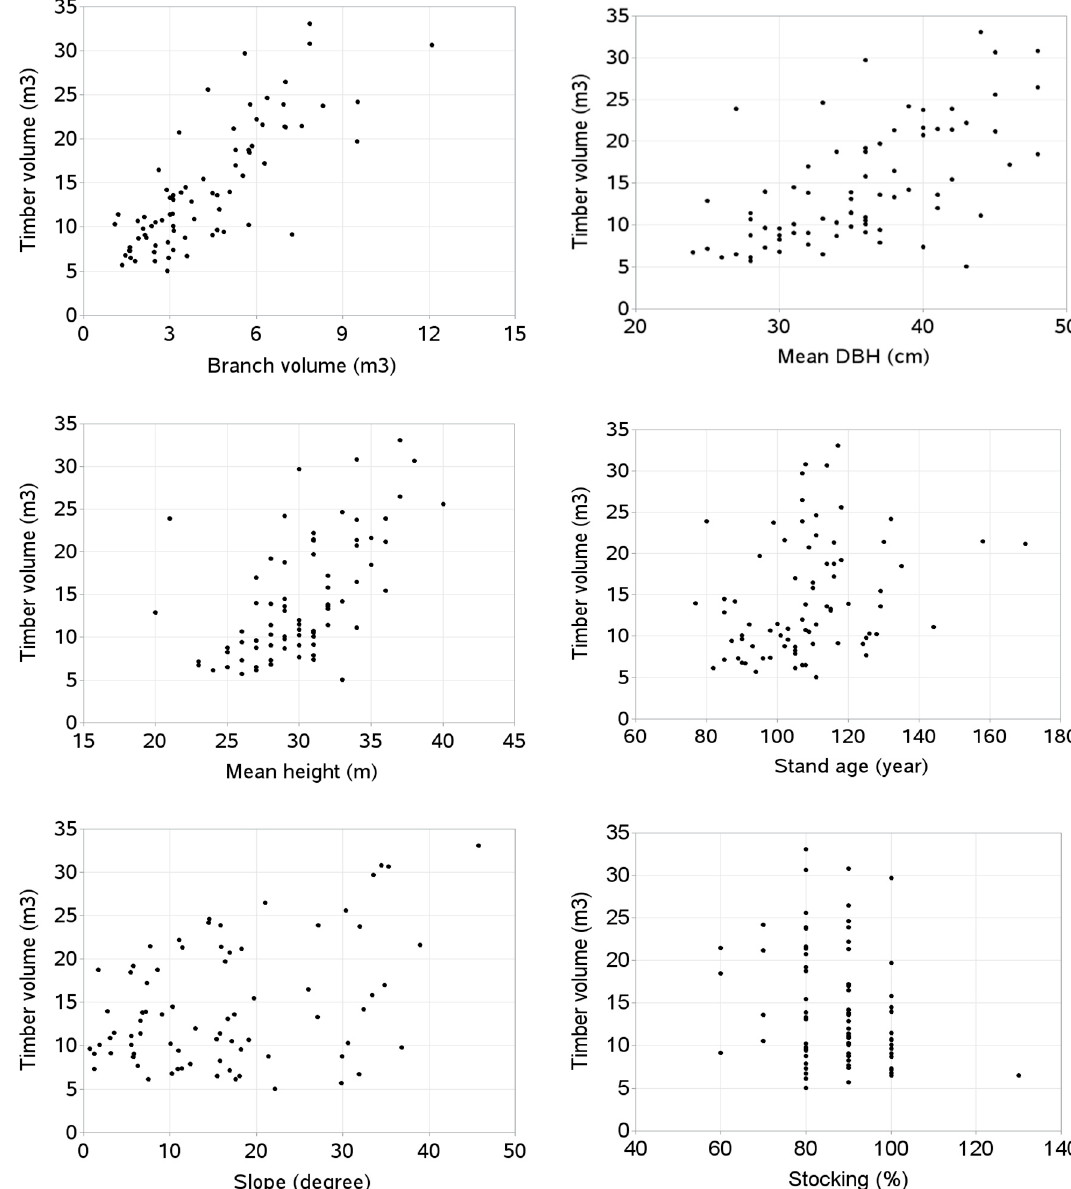
Figure 2. Scattered plots of timber volume versus other variables.